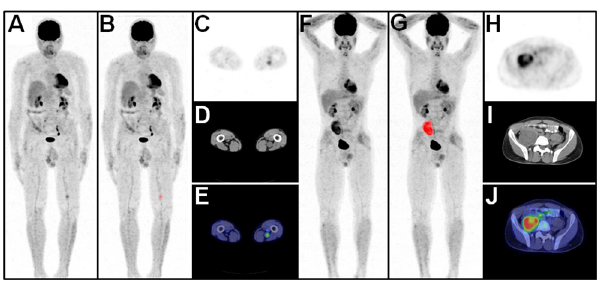
Fig 4. Solitary BPNST versus solitary MPNST. Maximum intensity projection PET image ( A ) of a patient with a solitary BPNST (SUV max / MTV / TLG: 2.6 / 2885 / 6488) in the left thigh with automatically delineated metabolically active tumors ( red ) ( B ), corresponding axial PET ( C ), CT ( D ) and fused PET/CT image ( E ). Maximum intensity projection PET image of a patient with a solitary MPNST (SUV max / MTV / TLG: 7.1 / 171328 / 633913) in the right pelvis ( F ) with automatically delineated metabolically active tumors ( red ) ( G ) with corresponding PET ( H ), CT ( I ) and PET/CT image ( J ).